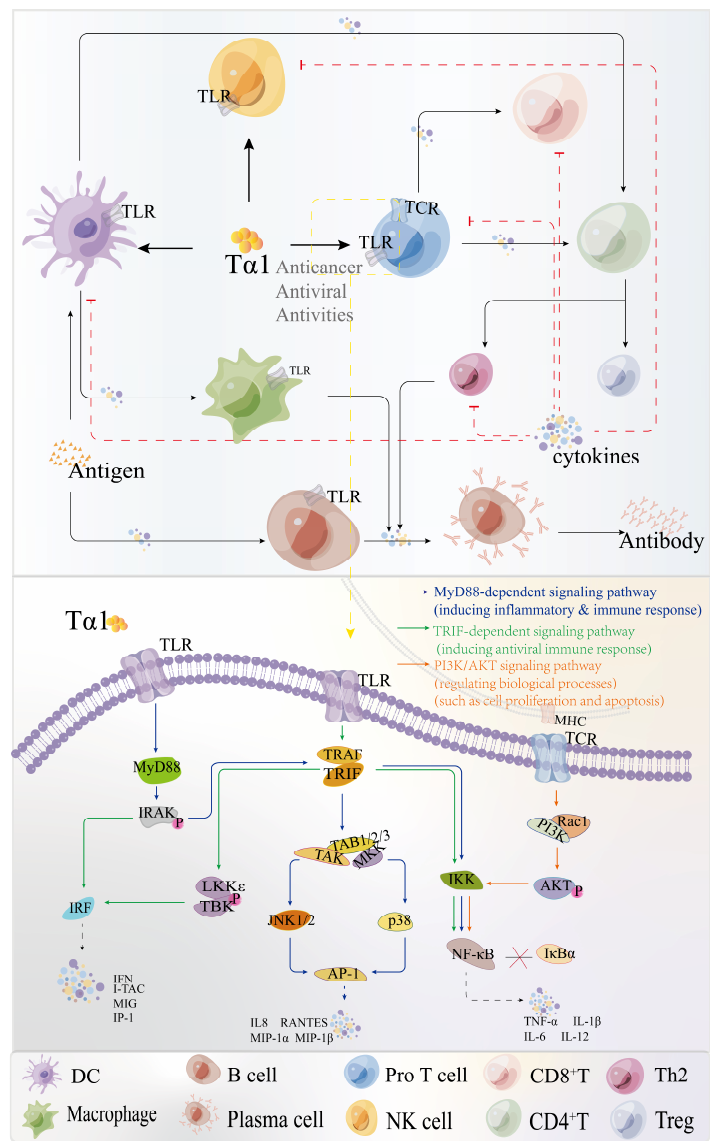
Figure 3. Immunomodulatory mechanism of T α 1 (DC: Dendritic cell; Pro T cell: Precursor T cell; NK cell: Natural killer cell; CD8 + T cell: Cytotoxic T cell; Treg cell: Regulatory T cell; Cytokines: IFN, IL-2, TNF, IL-10, et